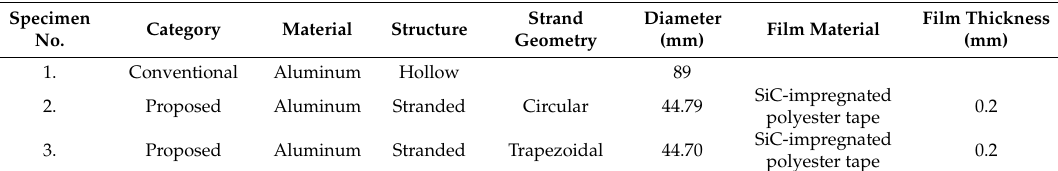
Table 3. Conductor specimens used in the comparative appraisal.